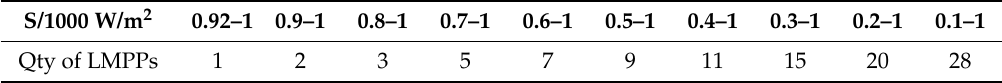
Table 1. Quantity of local maximum power point (LMPP)s under different irradiance